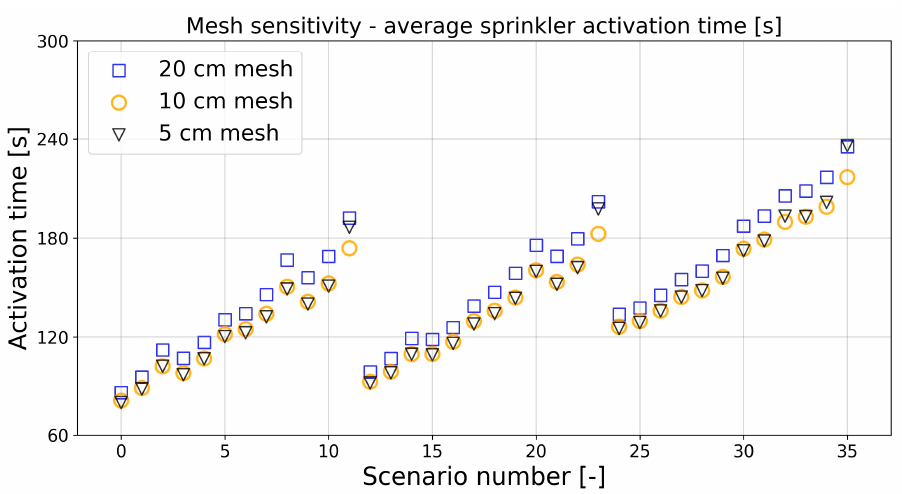
Figure 3. Activation time for different scenarios for three types of mesh investigated in the mesh sensitivity study.